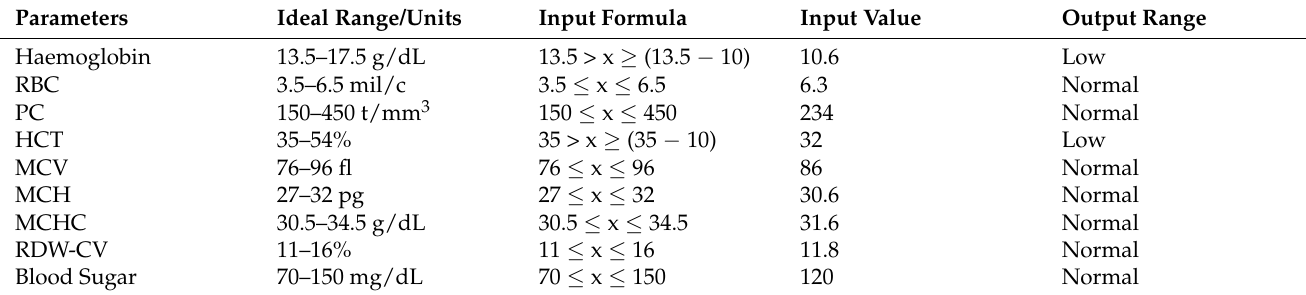
Table 10. Patient Blood Report